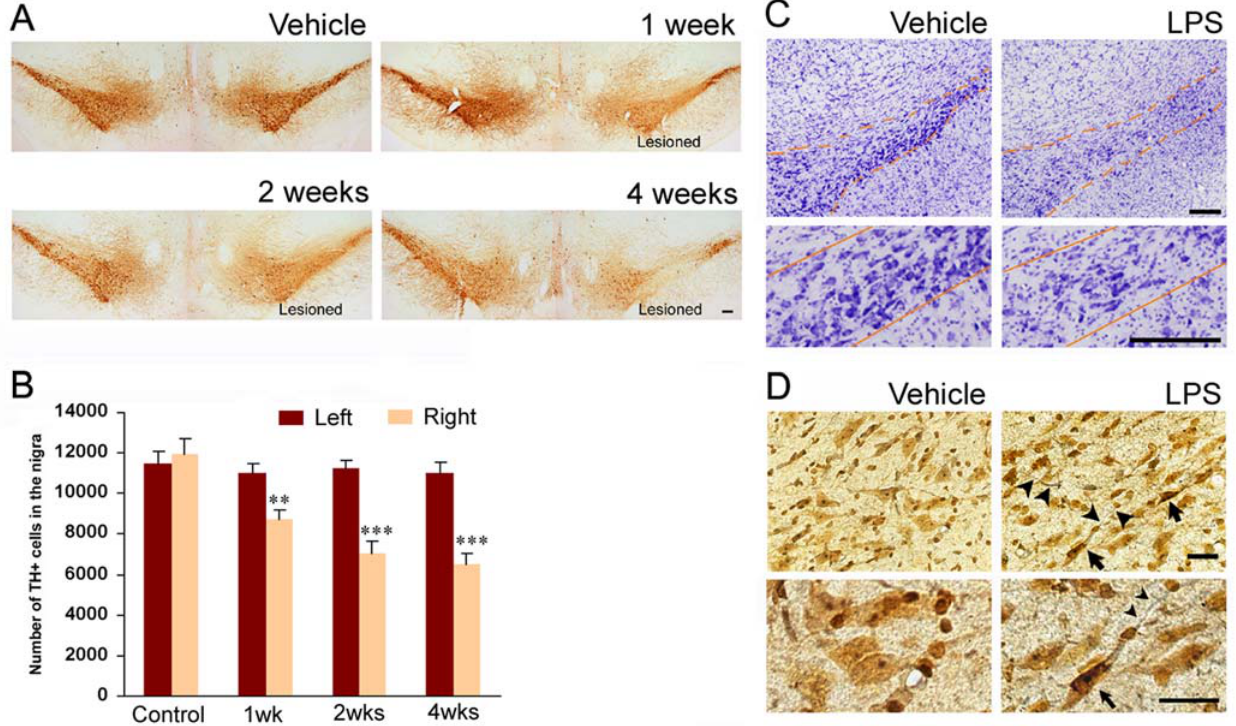
Figure 1. Progressive degeneration of the nigral dopaminergic neurons after intrastriatal LPS. (A) Representative TH immunostaining of coronal midbrain sections demonstrates that the numbers of TH-positive neurons and fibers in the substantia nigra pars compacta are gradually reduced by intrastriatal LPS injection. Note that TH-positive neurons in the medial substantia nigra pars compacta and ventral tegmental area are spared; scale bar: 200 m m. (B) Stereological cell counts of the TH-positive neurons in the substantia nigra pars compacta (n=5–6/group, ** p , 0.01, *** p , 0.001). (C) The substantia nigra pars compacta is outlined with an orange dashed line (top). High magnification image of Nissl stainings suggest loss of the nigral dopaminergic neurons, at four weeks following LPS injection (bottom); scale bar: 200 m m. (D) Silver staining is hardly seen in the substantia nigra ipsilateral to vehicle treatment. However, abundant silver grain-deposits are observed in the neurons (arrows) and fibers (arrow heads) in the substantia nigra ipsilateral to the intrastriatal LPS injections, indicating there is ongoing neurodegenerative process in the region. Scale bar: 20 m m.